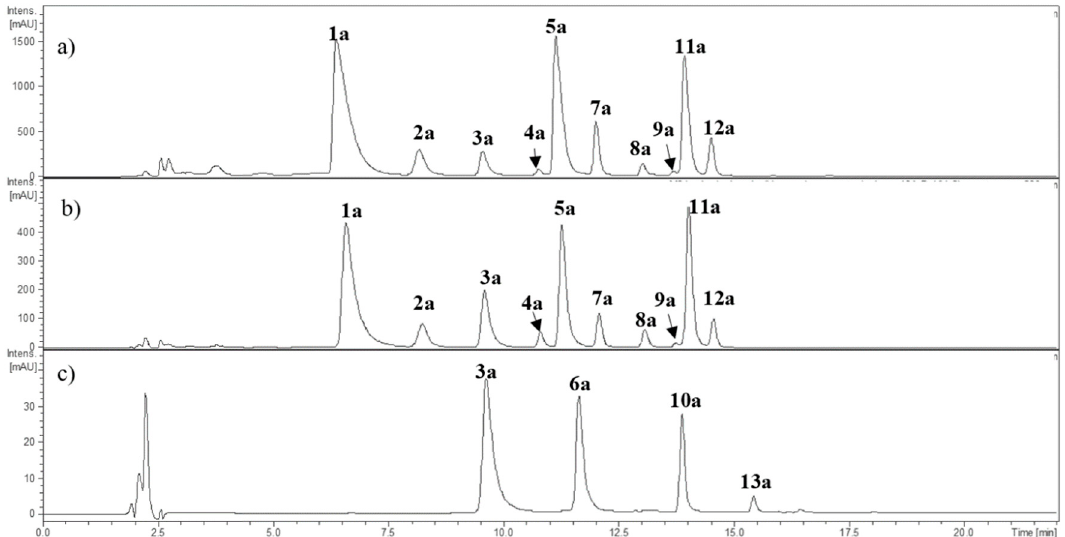
Figure 2. HPLC-DAD chromatogram (520 nm) of the anthocyanins from ( a ) Berberis microphylla , ( b ) Berberis darwinii , and ( c ) Fragaria chiloensis . The numbers correspond to Table 2.